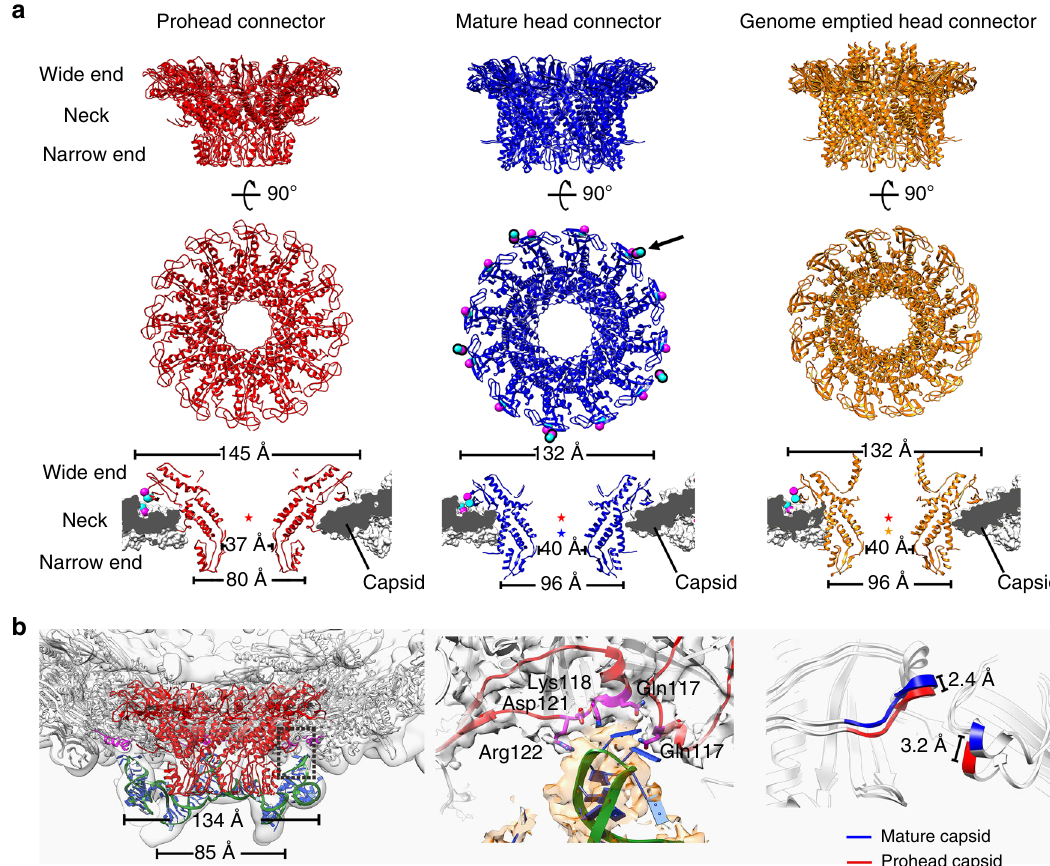
Fig. 6 Structural comparisons of the connectors. a Top and middle: ribbon diagrams showing the top and side views of the prohead (red), the mature head (blue) and the genome emptied head connectors (orange); bottom: thin sections of different connector in corresponding capsid showing the conformational and positional differences between the connectors. Residues Arg94 and Glu103 of the mature head connector and residues Lys297 and Asp298 of the HK97-P subdomain are represented using balls (blue for Arg and Lys, magenta for Asp and Glu). Center of gravity for each connector is indicated with a star to allow comparison of the positions of the connectors relative to the capsid. b Left: ribbon diagrams showing the pRNAs on the prohead. The backbone of the pRNA is shown in green with the bases colored blue. The prohead connector is colored red. Residues in contact with the pRNA are shown in magenta; middle: interactions between the pRNAs and the capsid E loops. Residues in contact with the pRNA are colored magenta. The E loops are colored red. The pRNA density is shown in transparent orange; right: conformational changes of the E loops upon head